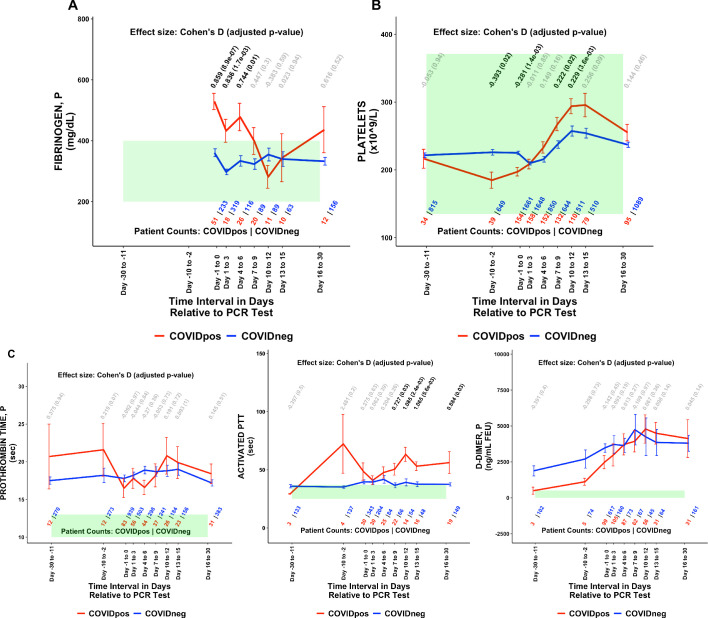
COVIDpos patients show distinctly opposite temporal trends in fibrinogen and platelet counts starting at the time of diagnosis.Longitudinal trends of COVIDpos versus COVIDneg (matched) patients for the following lab tests: (A) fibrinogen, plasma, (B) platelets, and (C) other coagulation-related tests including prothrombin time (PT), activated partial thromboplastic time (aPTT), and D-dimers. For any window of time during which at least three patients in each cohort had test results, data are shown as mean with standard errors. The normal range for each lab test is shaded in green. Values given horizontally along the top of the plot are Cohen’s D statistics comparing the COVIDpos and COVIDneg (matched) cohorts along with the BH-adjusted Mann-Whitney test p-values. Significant differences (adjusted p-value <0.05) are shown in black, while non-significant values are shown in gray. Values given horizontally along the bottom of the plot are the numbers of patients in the COVIDpos and COVIDneg cohorts, respectively (i.e. # COVIDpos | # COVIDneg). For certain lab tests, some data points are missing because these time windows had fewer than three data points in the COVIDpos cohort.